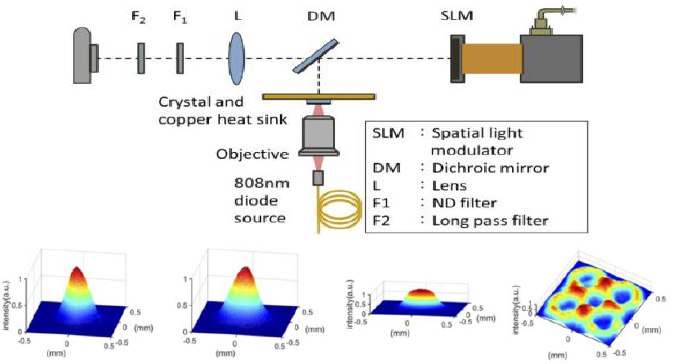
Figure 8. Schematic of the structured light laser and the various light fields (Adapted from an open-access source Ref. [76]).